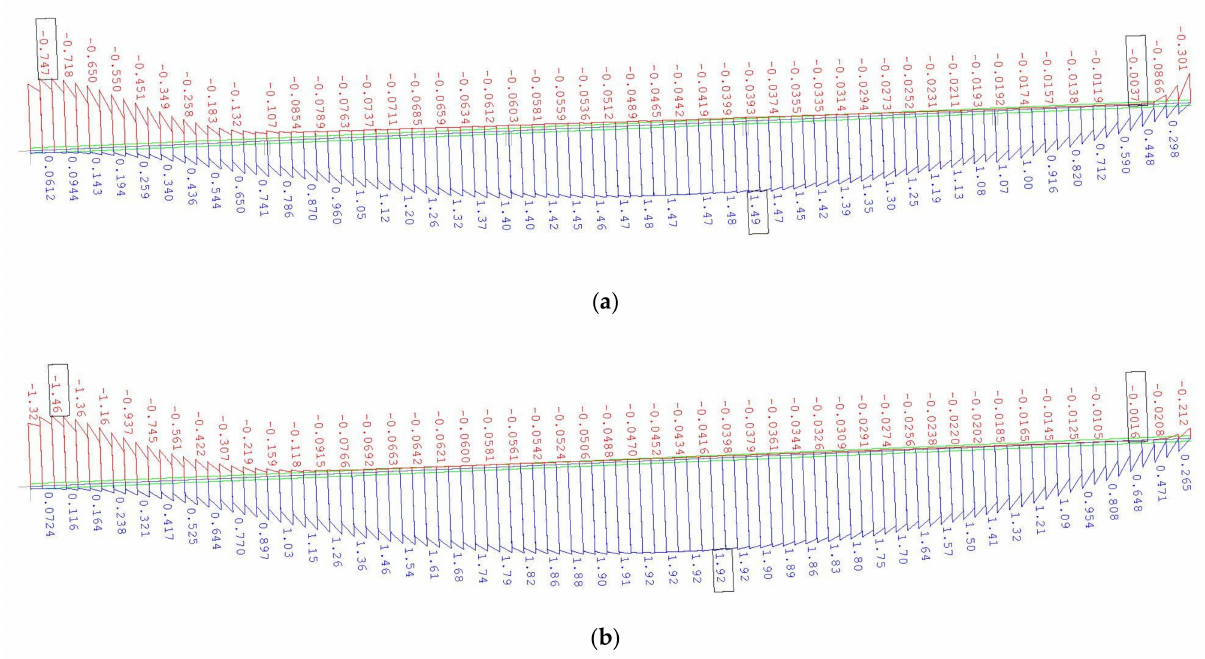
Figure A5. Characteristic values of bending moments M (kNm) under the moving load q of class C in the right span: ( a ) Outer girder; ( b ) inner